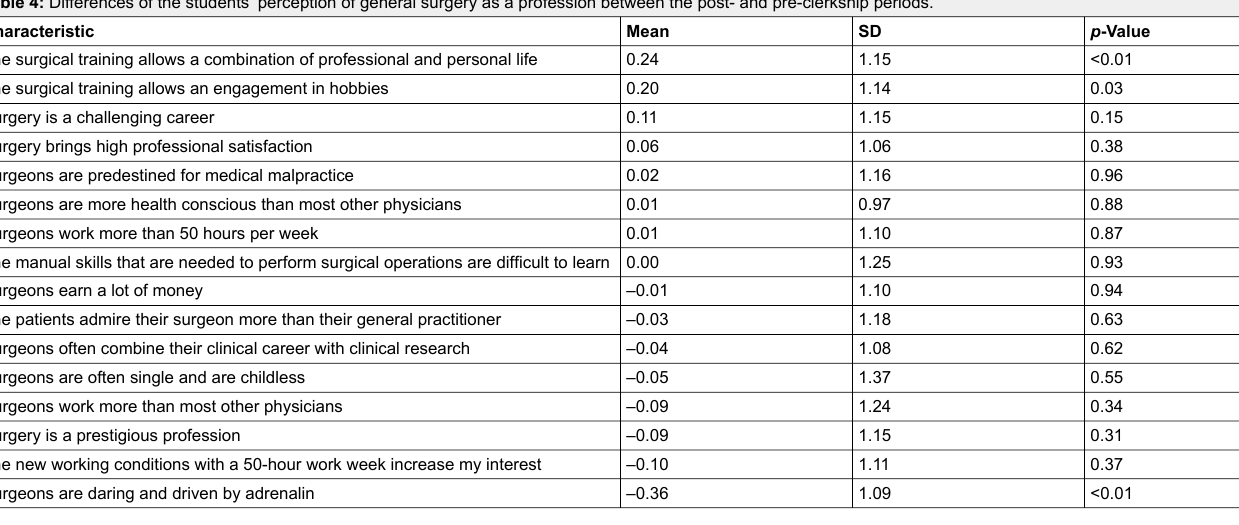
Table 4: Differences of the students’ perception of general surgery as a profession between the post- and pre-clerkship periods. Characteristic